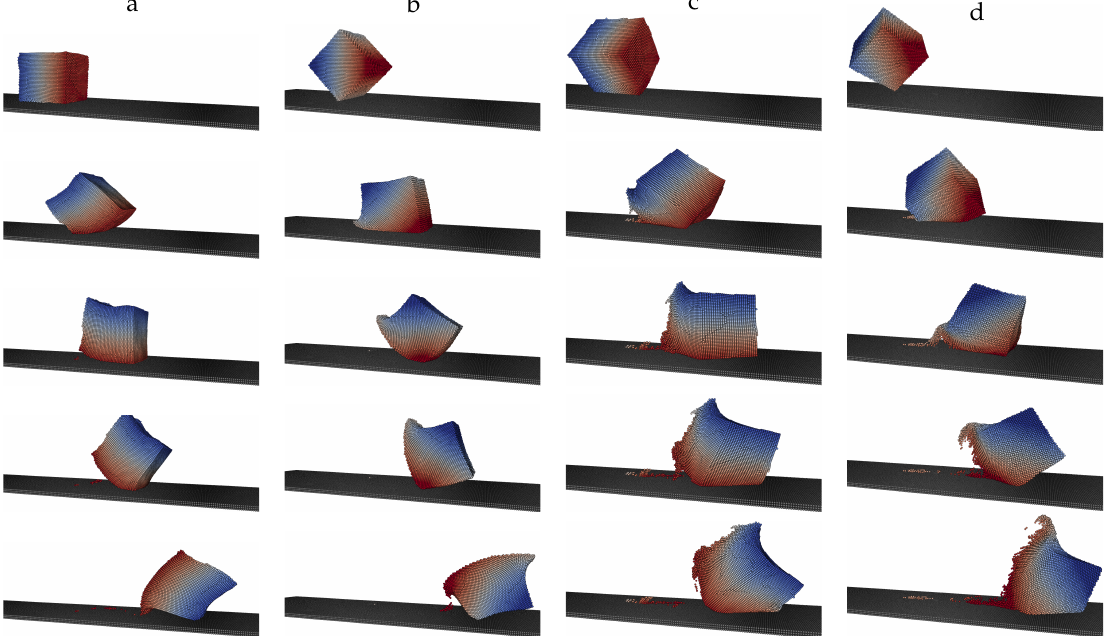
Figure 18. Time series of the impact of the cube presenting its face ( a ), edge perpendicular ( b ) and parallel ( c ) to the tangential velocity and its corner ( d ) for an oblique impact of θ i = 75 ◦ . Particles are colored by their unique identity